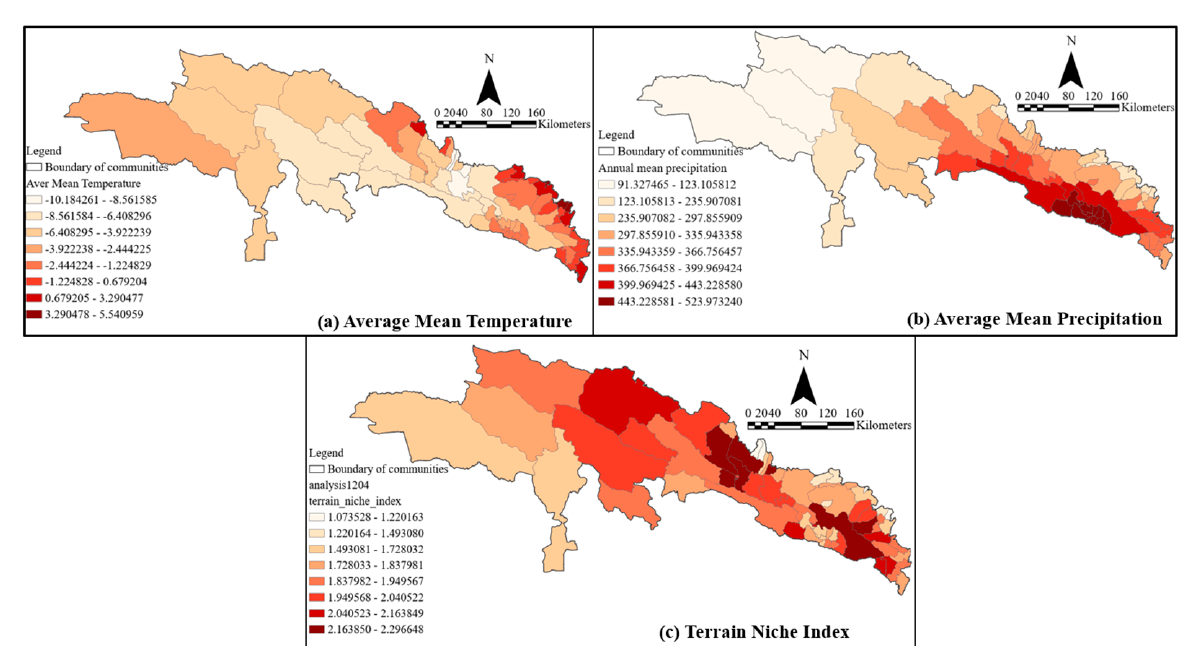
Figure 6. The spatial distributions of natural factors: ( a ) the average mean temperature; ( b ) the average mean precipitation; ( c ) the terrain niche index.